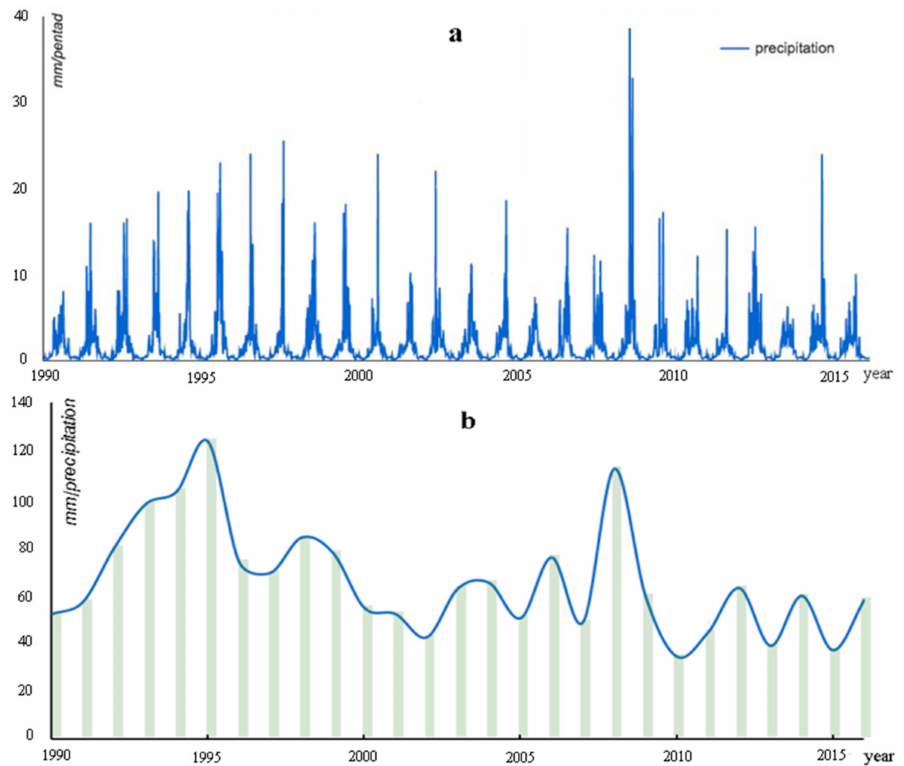
Figure 12. Precipitation of Denko County from 1990 to 2016 ( a ) and the sum of precipitation from July to August ( b